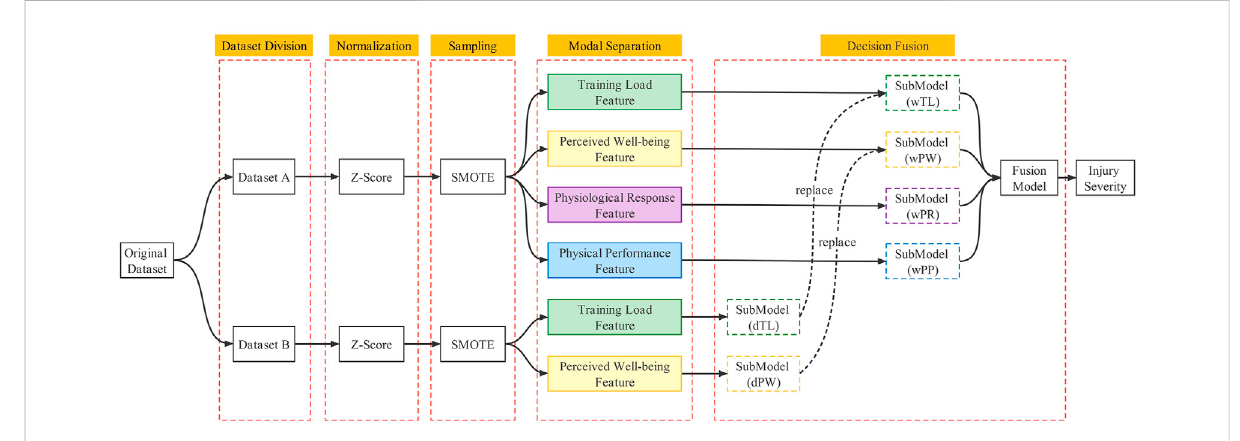
FIGURE 2 Schematic diagram of the multimodal model